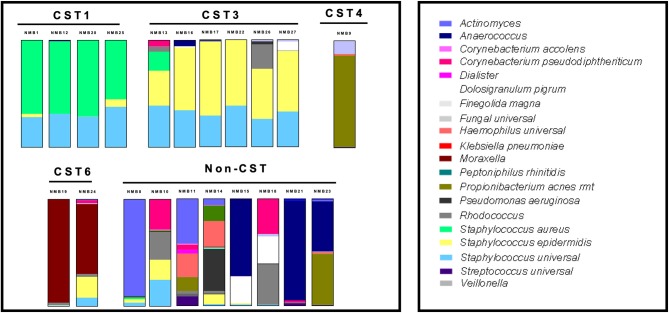
Diverse profiles of transplanted human NMB communities after 48 h of cultivation on mature NEC ALI cultures. CST1, 3, 4, and 6 community profiles were reproducibly cultivated in concordance with the donor profiles. Eight communities that did not match a CST also were successfully cultivated. These communities were tested extensively on NEC03, 05, 08, and 09 with average proportional bar charts presented (n = 3–6 replicates for each of the 4 NEC).